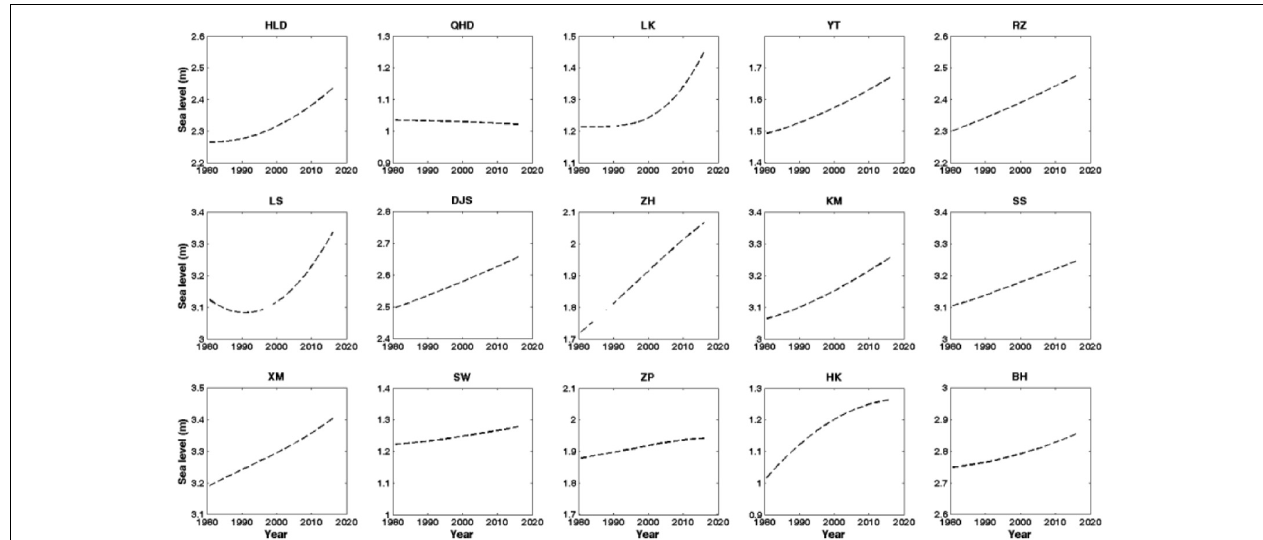
FIGURE 4 | Long term trends of the extreme sea levels at 15 tide gauges along the Chinese coast.